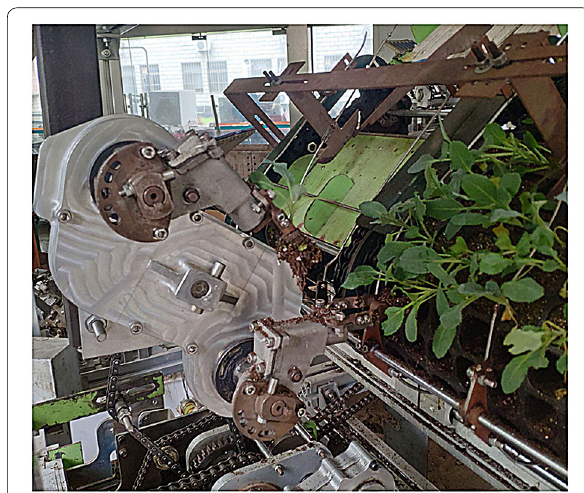
Figure 20 Test of picking up